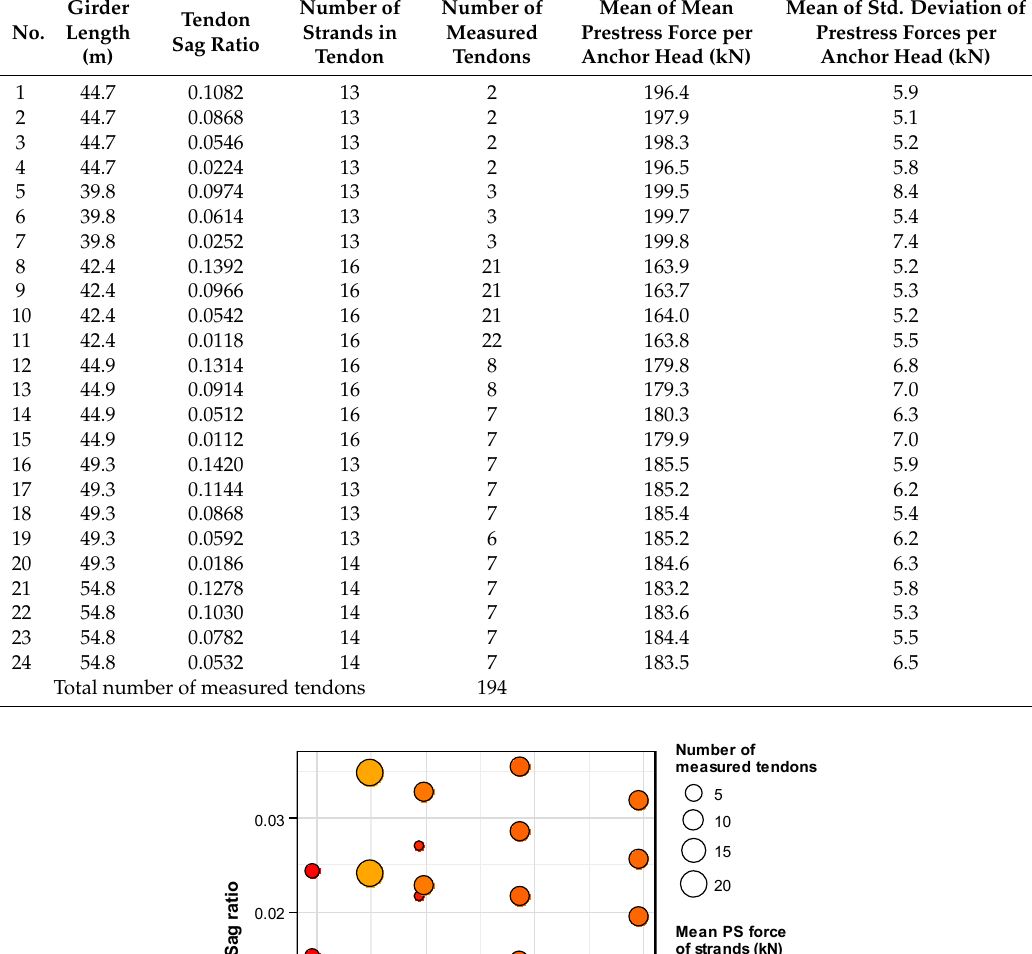
Table 1. Mean and standard deviation of prestress force per anchor head based on structural factors of considered PSC structures.